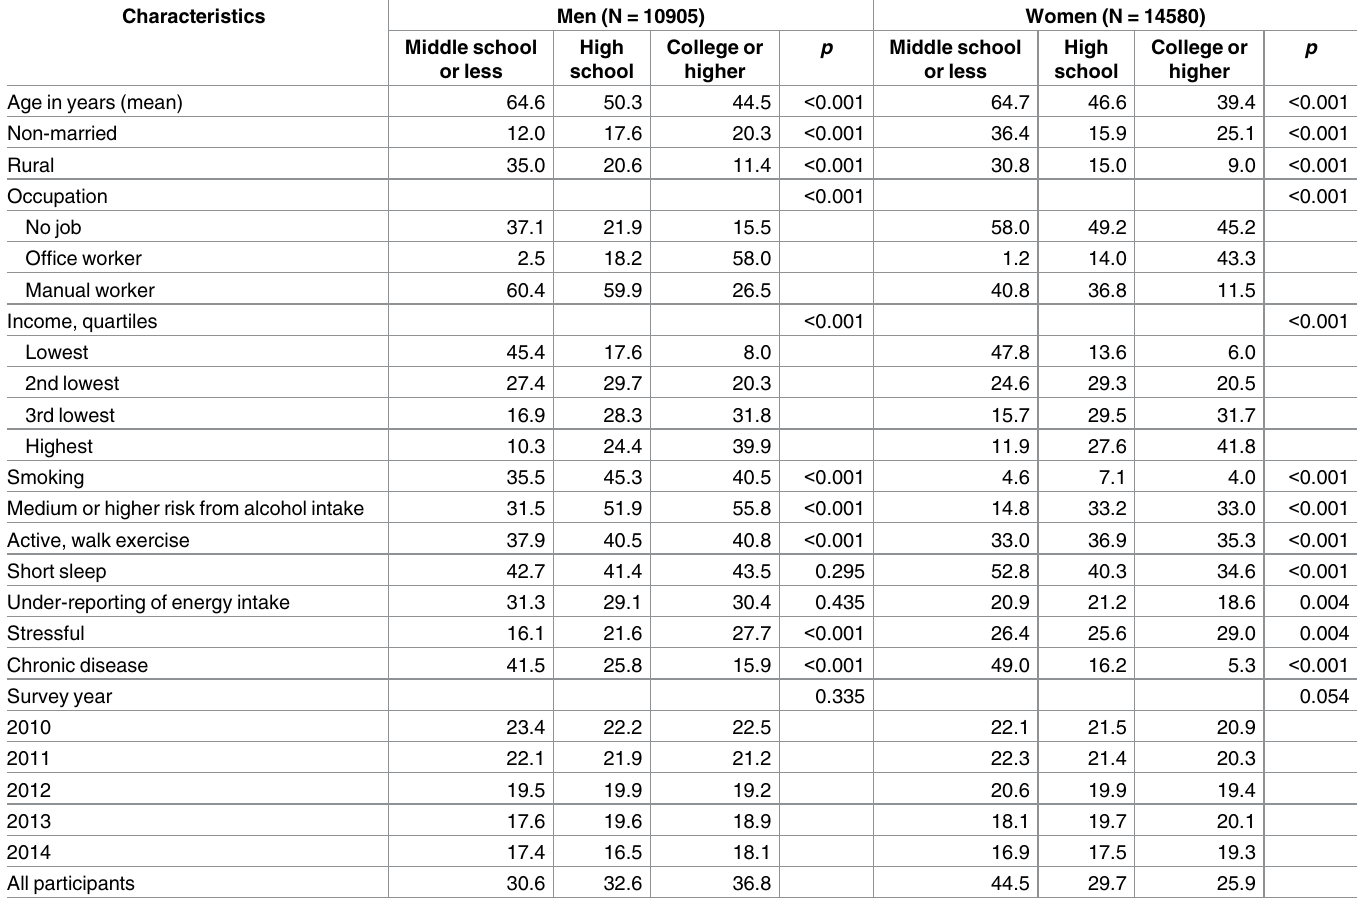
Table 1. General characteristics of the study sample by sex and education